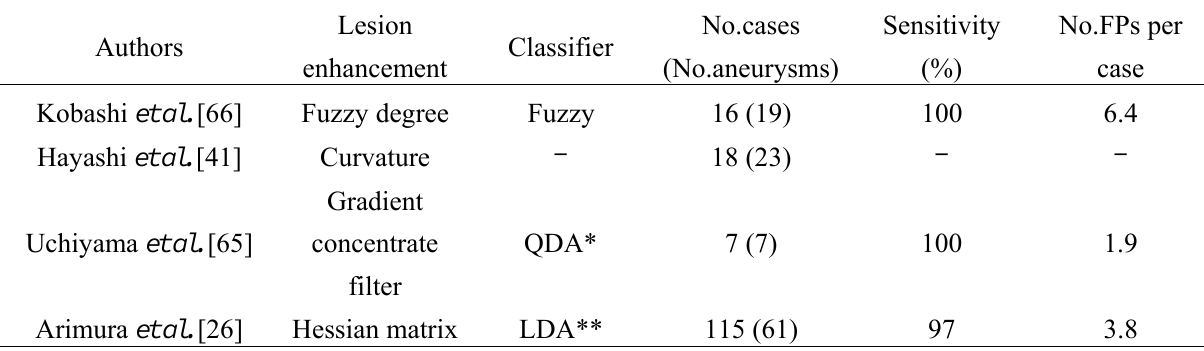
Table 1 . Comparison of methods and performance of CAD systems for detection of intracranial aneurysms using MRA.